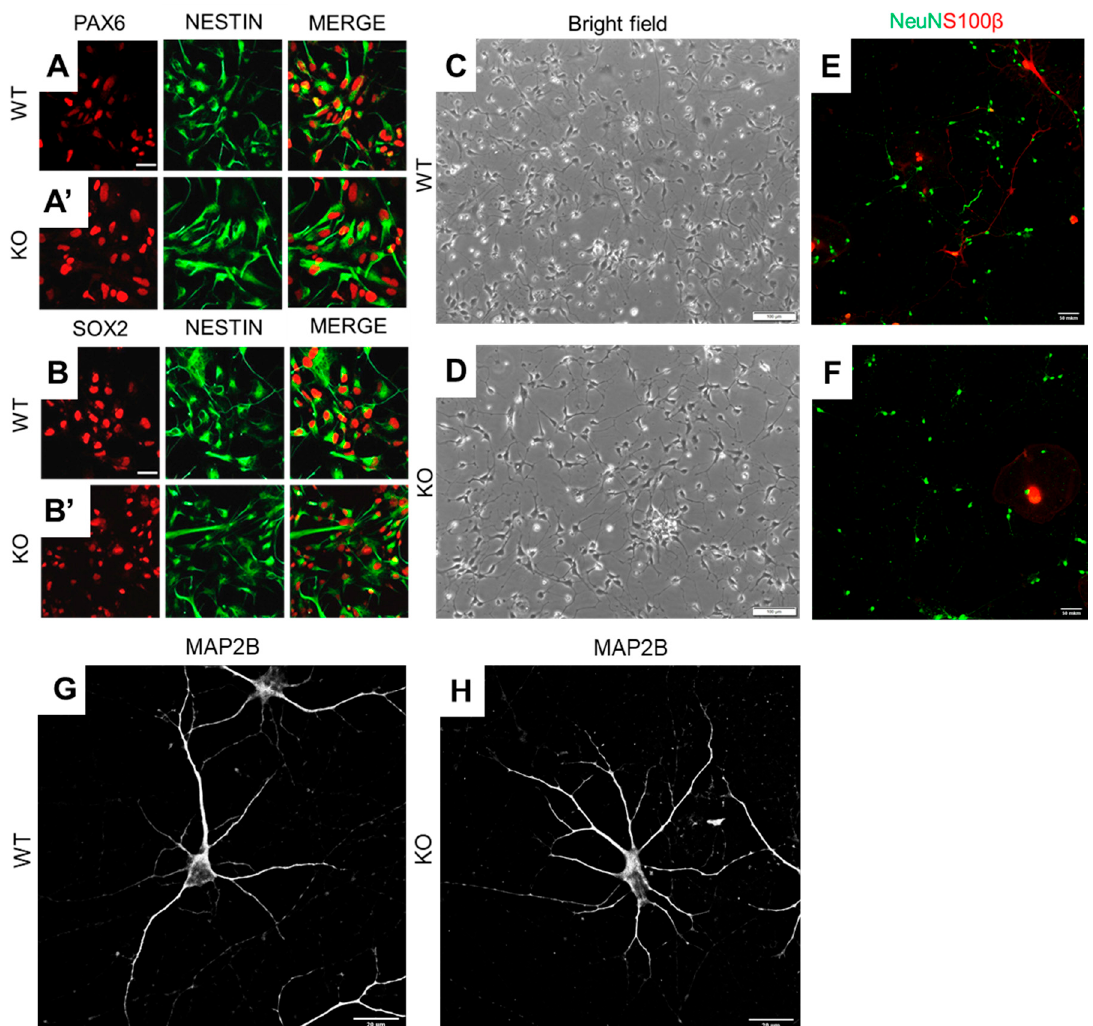
Figure 2. Efficient derivation of NPCs and neurons from wild-type and MT5-MMP-deficient hiPSCs. ( A , B ) Wild-type and MT5-MMP-deficient (KO) hiPSCs were efficiently differentiated into NPCs co-expressing the paired box 6 (PAX6, red) and nestin (green) ( A , A’ ), as well as the SRY (sex-determining region Y)-box 2 (SOX2, red) and Nestin (green) markers ( B , B’ ). Scale bar 20 μ m. ( C , D ) Representative bright-field images of wild-type ( C ) and MT5-MMP-deficient NPCs ( D ) undergoing neuronal differentiation at DIV3, scale bar 50 μ m. Note that multiple neurite-like protrusions were already observed at this early stage of differentiation, with no clearly distinct morphology between neurons of both genotypes at this stage. ( E–H ) Representative images of immunolabeled hiPSC-derived neuronal cultures immunolabelled with antibodies against the neuron-specific marker NeuN (green) and the astrocyte-specific marker S100 β (red) ( E , F , scale bar 50 μ m) after 60 days of differentiation (DIV60). In addition, cells expressed neuron-specific cytoskeletal protein MAP2B ( G , H , scale bar 20 μ m).